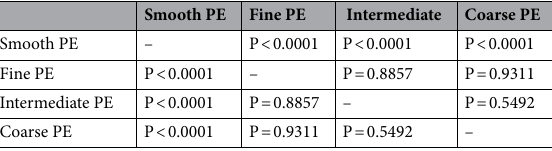
Table 3. Tukey post-hoc test results from maximum shear load performance across polyethylene substrates.